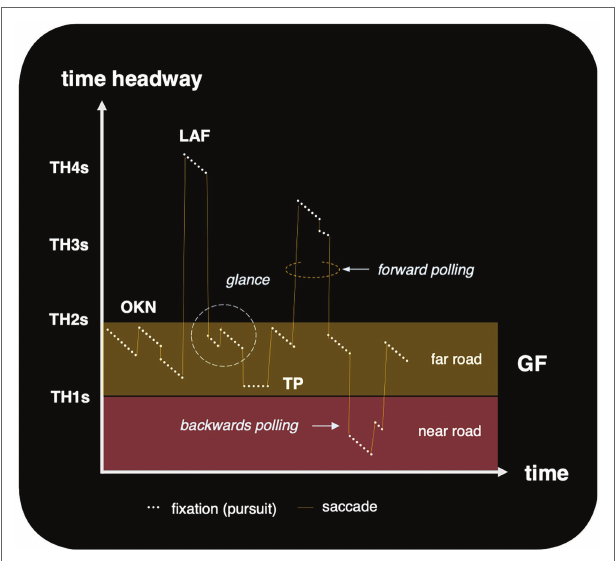
FIGURE 5 | Schematic outline of the primary eyes-on-the road gaze strategies. When fixating a waypoint location the time headway reduces as one approaches it; the “fixation” is an oculomotor pursuit (when fixating any fixed reference point in the 3D scene one is moving relative to, the fixation is a pursuit). When fixating a travel point the time headway is constant. Also note that a “fixations” reported in natural tasks are often “glances” (i.e., the criterion of how large a saccade must be to “break fixation” can different in naturalistic and oculomotor research). TH, time headway to the point of fixation; OKN, optokinetic nystagmus; TP, tangent point; GF, guiding fixations; LAF, look- ahead